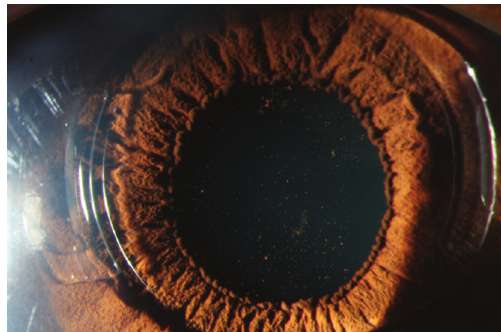
Figure 4: Pigment deposits on the posterior surface of a foldable toric Artiflex pIOL one week after